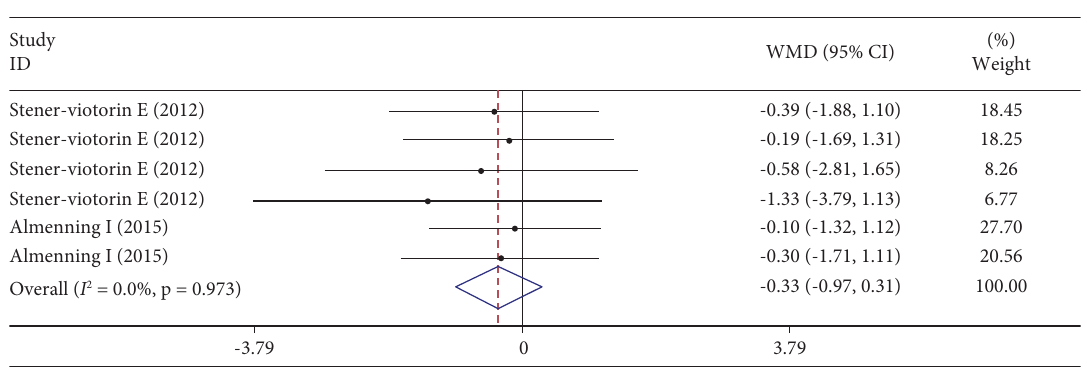
Figure 3: Forest plot for adiponectin studies ( n � 6). Te graph depicts WMD and 95% CI for individual studies and the pooled estimate. Adiponectin Funnel plot with pseudo 95% confidence limits 1.51.50